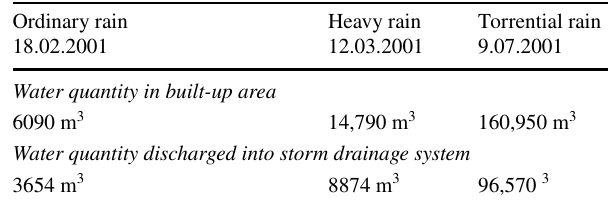
Table 2 Quantity of precipitation water discharged into storm drain- age system depending on precipitation intensity Ordinary rain 18.02.2001